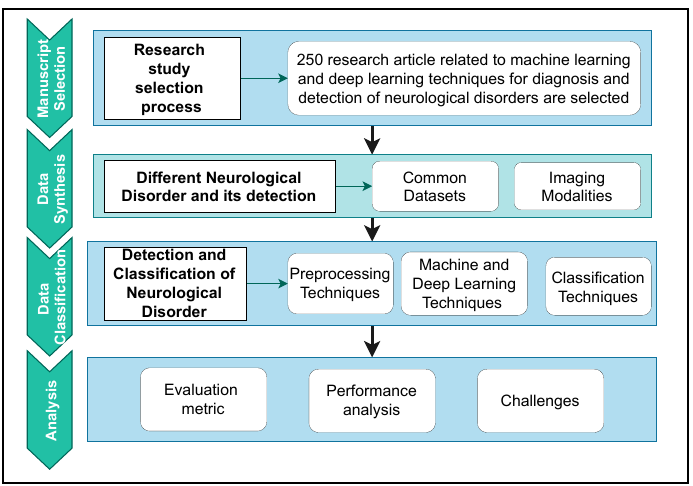
Figure 2. Workflow of neurological diseases detection and diagnosis